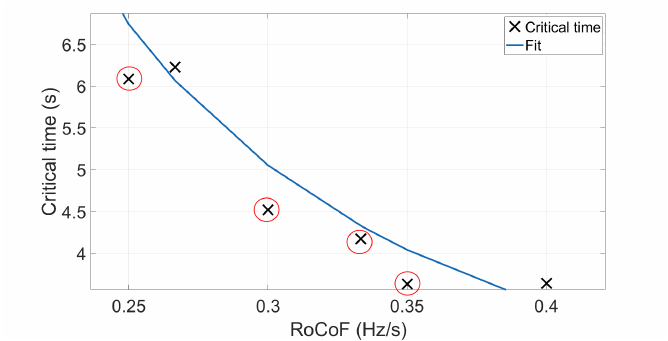
Figure 15. Overestimation of critical time leading to UFLS in the European-scale